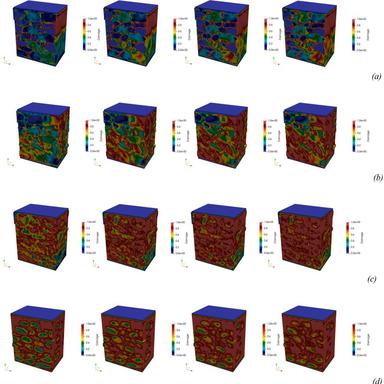
Wall#1 (a) Wall#2 (b) Wall#3 (c) and Wall#4 (d) damage evolution for 25%, 50%, 75% and 100% of Fmax (micro-modelling approach).